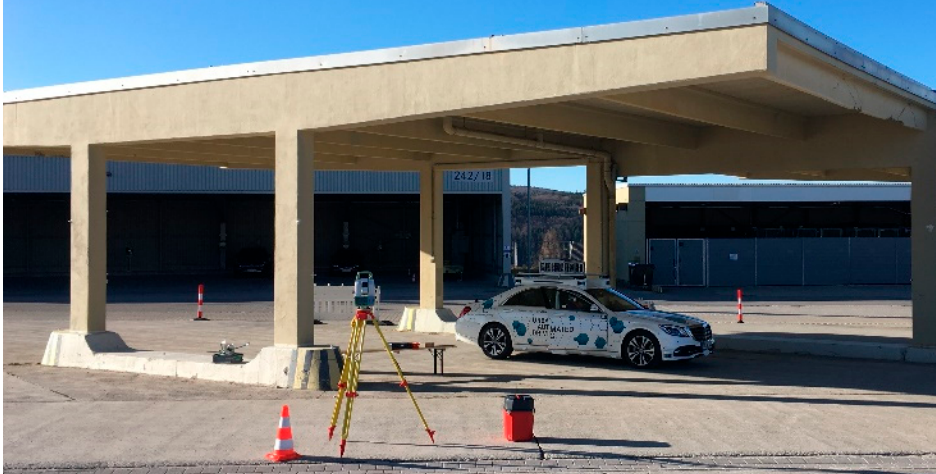
Figure 2. Setup of the tracking system at the test site, consisting of one MS60 (on a tripod in the front) and a camera rig on the roof of the car.